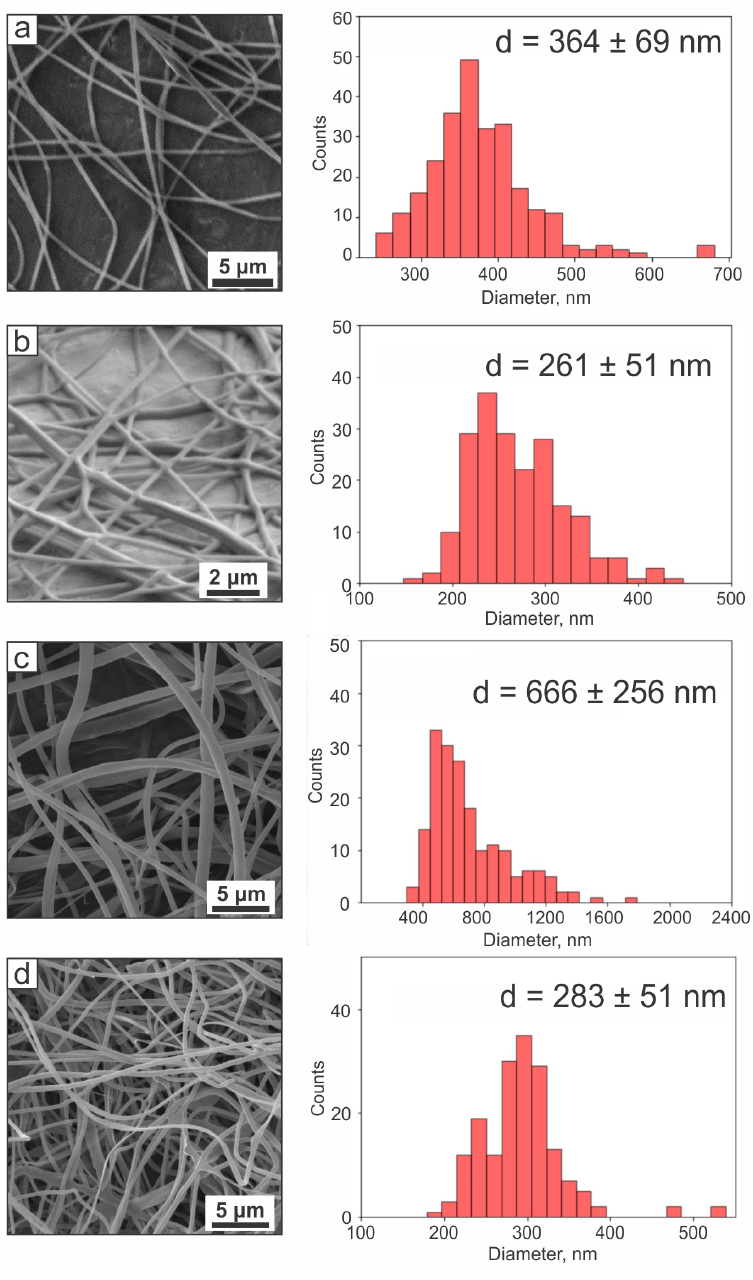
Figure 2. SEM images of fibers with diameter distribution of ( a ) core PVA-PEG-SiO 2 ; ( b ) core– shell PVA-PEG-SiO 2 @PVA-GO; ( c ) core PVA-PEG-SiO 2 -1x-CHX; ( d ) core–shell PVA-PEG-SiO 2